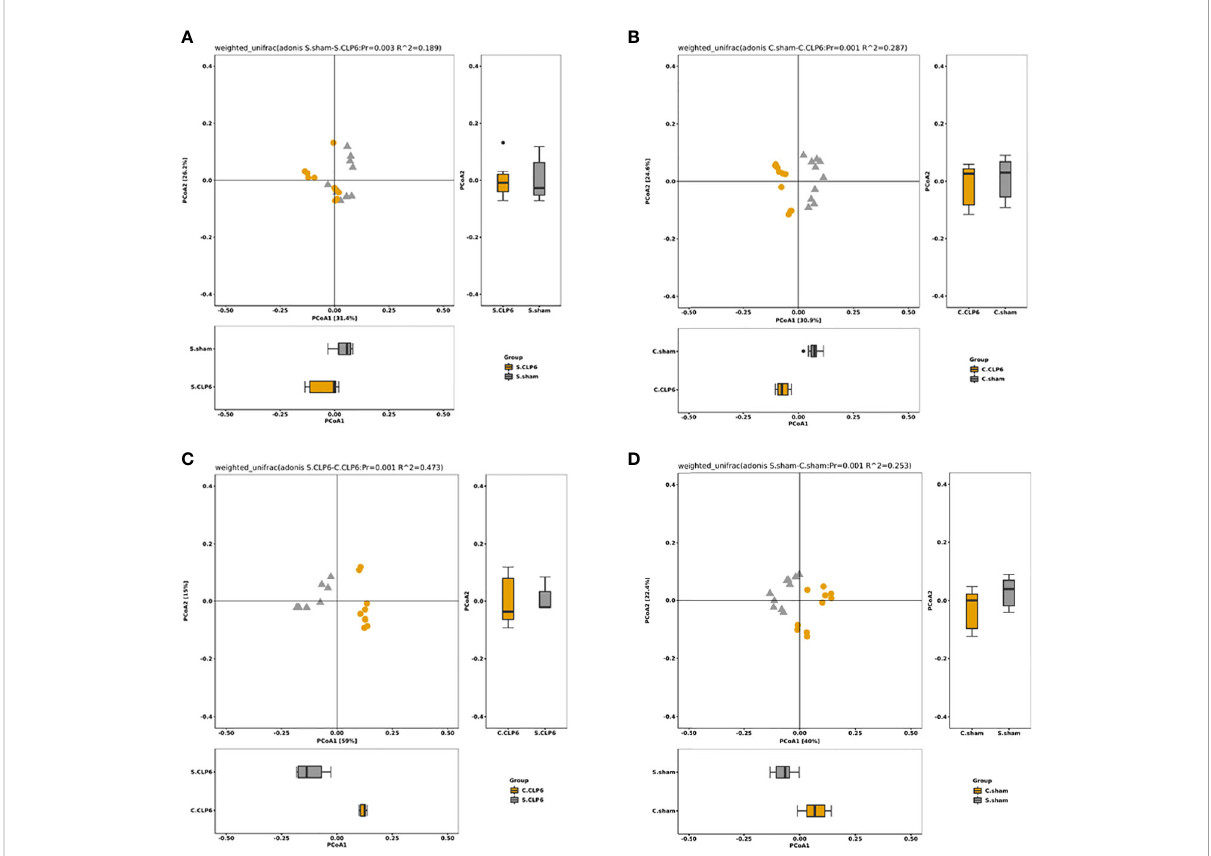
FIGURE 5 The OTU PCA and PCoA weighted analysis of the difference in gut microbiota. Weighted UniFrac was included in the calculation on the basis of UniFrac to distinguish differences in species abundance. (A) Species abundance in the small intestine of the sham group and the CLP6h group was signi fi cantly different ( p = 0.003). (B) Species abundance in the colon of the sham group and the CLP6h group was signi fi cantly different. ( p = 0.001). (C) In the CLP6h group, the composition of the microbiota in the small intestine and colon was signi fi cantly different ( p = 0.001). (D) In the sham group, the composition of the microbiota in the small intestine and colon was signi fi cantly different ( p =